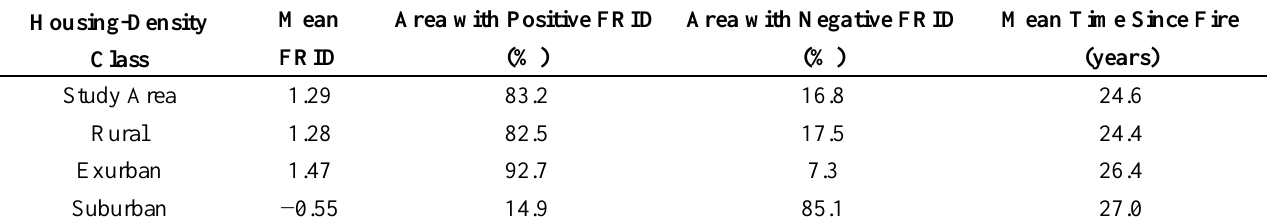
Table 3. Fire Return Departure (FRID) index values by housing-density class. Positive FRID values indicate fuel storage and moderate to high potential for fire, whereas negative numbers indicate a limited amount of fuel storage and low potential for fire.